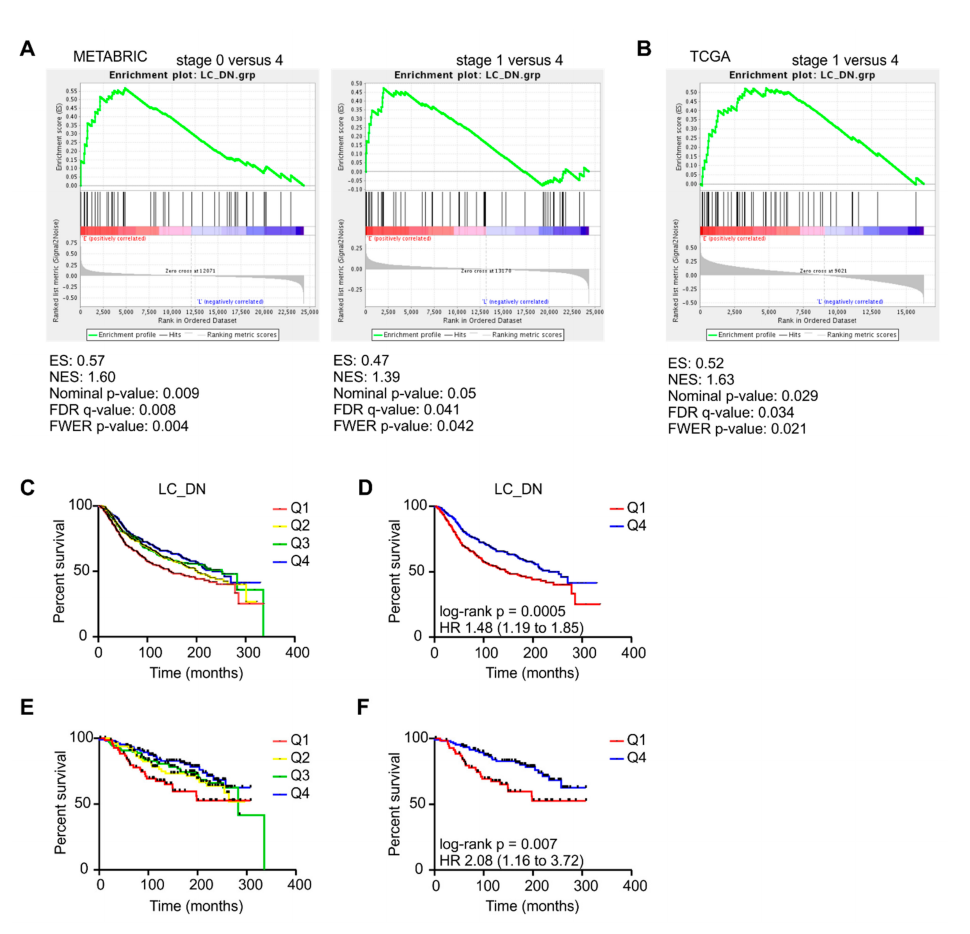
Figure 7. Correlation of an early PyMT CAF signature with human mammary carcinoma patient